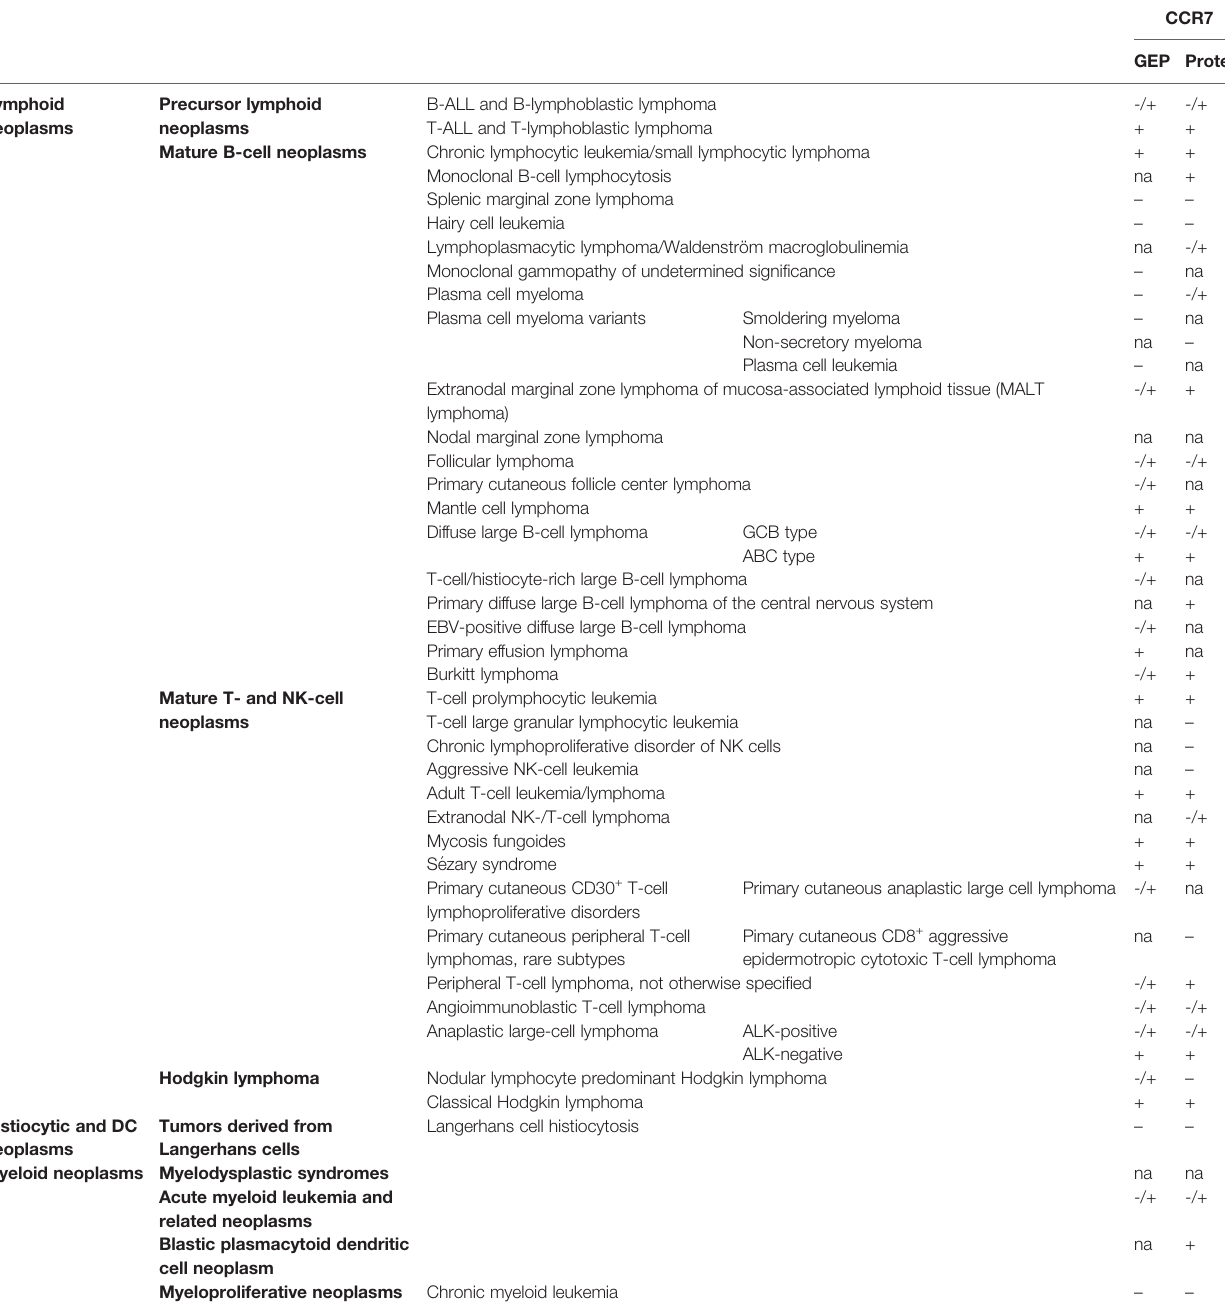
TABLE 1 | Summary of blood cancers with reported CCR7 expression studies (following 2016 WHO classi fi cation of blood neoplasms)